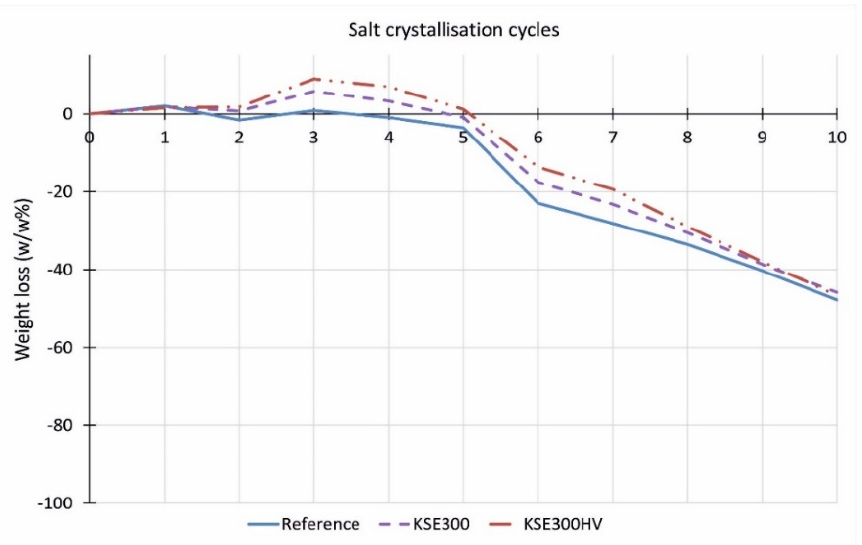
Figure 14. Weight loss of untreated and treated medium-grained porous limestone from Fert ő rákos (FR) after salt crystallization cycles.